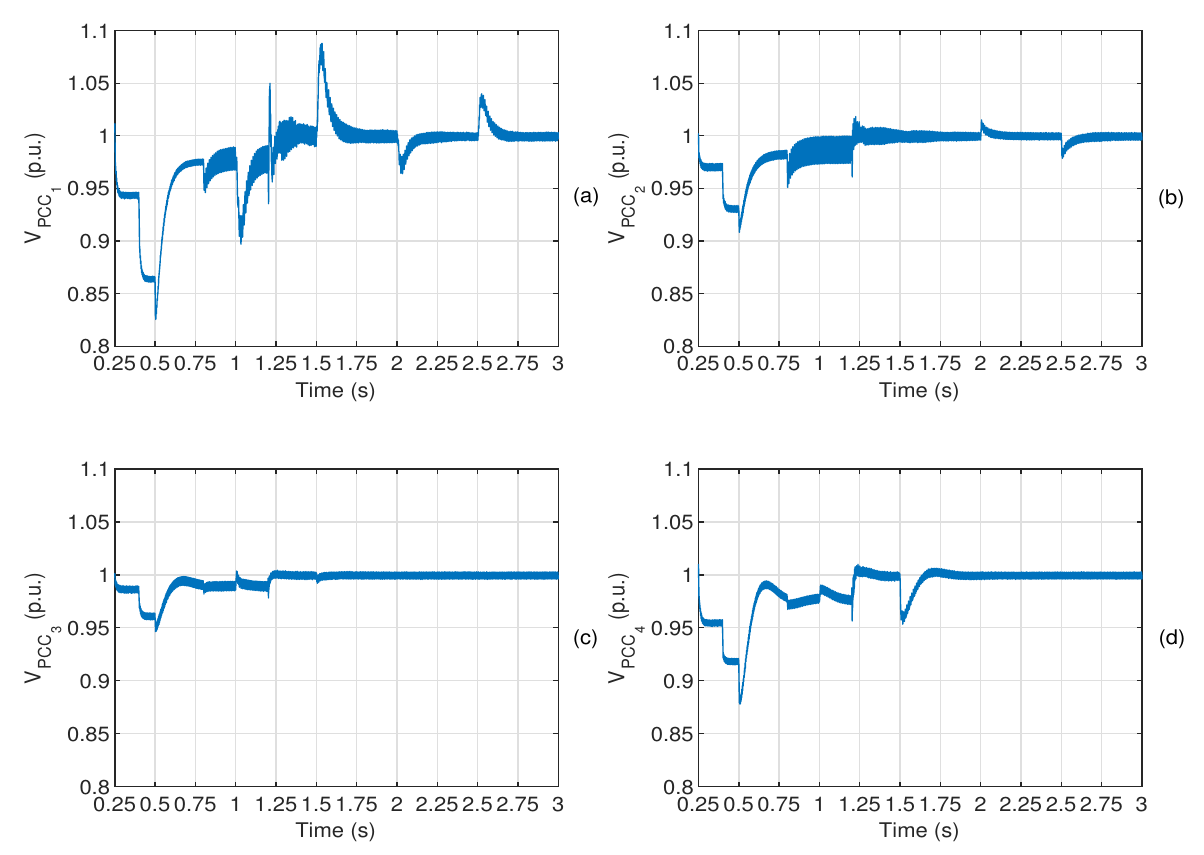
, ( b ) V PCC , ( c ) V PCC , and ( d ) V PCC . Figure 8. Evolution of the voltages at the four PCCs in p.u: ( a ) V PCC 2 3 1 4 The voltage across the DC bus is plotted in Figure 9: A double frequency ripple is present when imbalances begin to be compensated [18]. Moreover, even voltage harmonics are present in the voltage waveform when the harmonics of the grid currents are com- pensated by each terminal of the HVDC system. However, the DC value of the voltage across the DC bus remains around 80 kV, despite the disturbances caused by changes in the references of the active powers of the terminal power dispatchers.